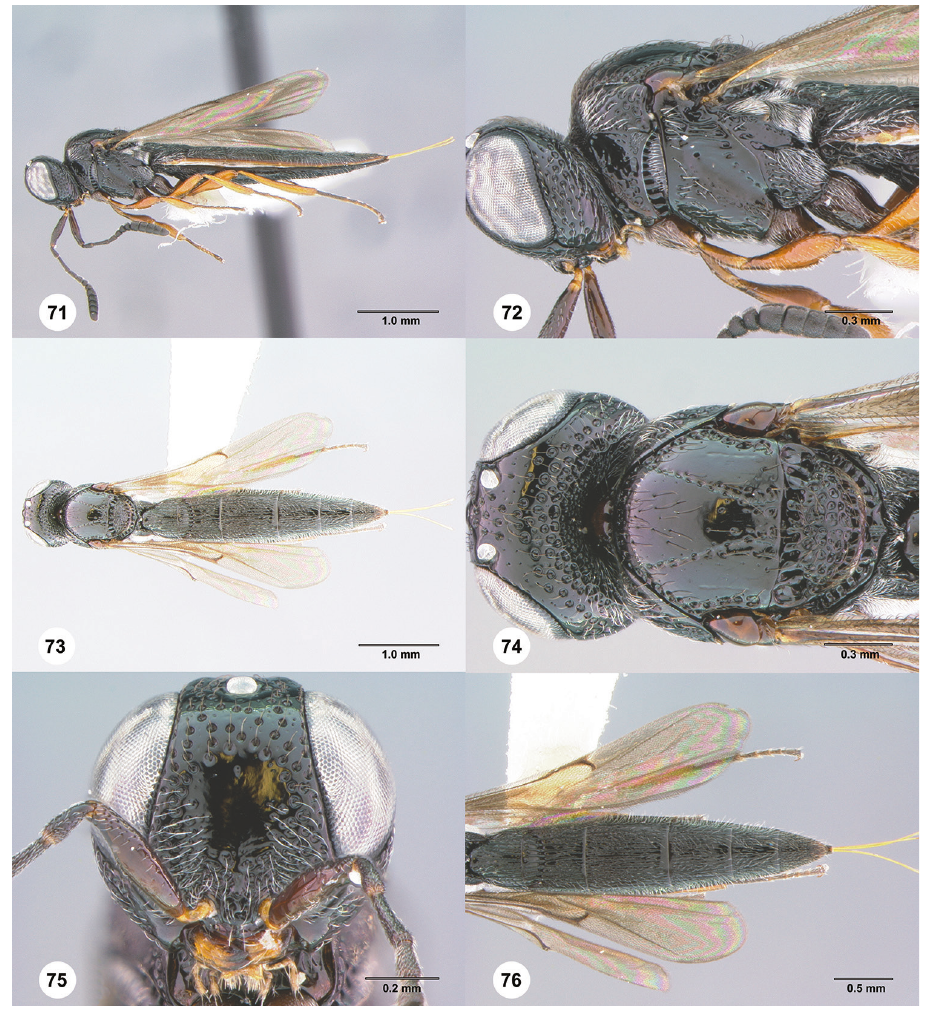
Figures 71–76. Habroteleia salebra sp. n., female, holotype (OSUC 688076). 71 Lateral habitus 72 Head and mesosoma, lateral view 73 Dorsal habitus 74 Head and mesosoma, dorsal view 75 Head, anterior view 76 Metasoma and wings, dorsal